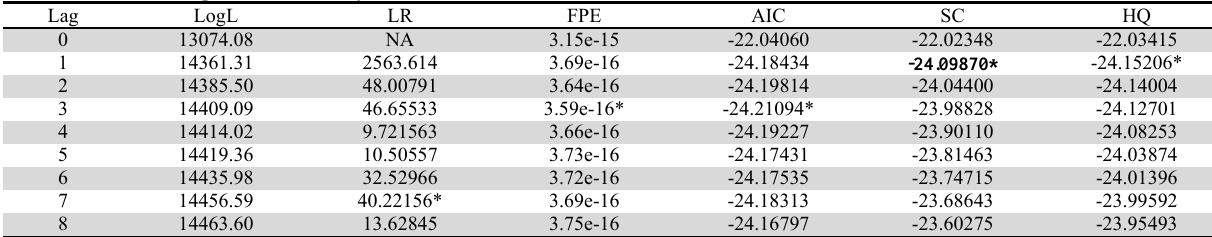
The results of regression analysis